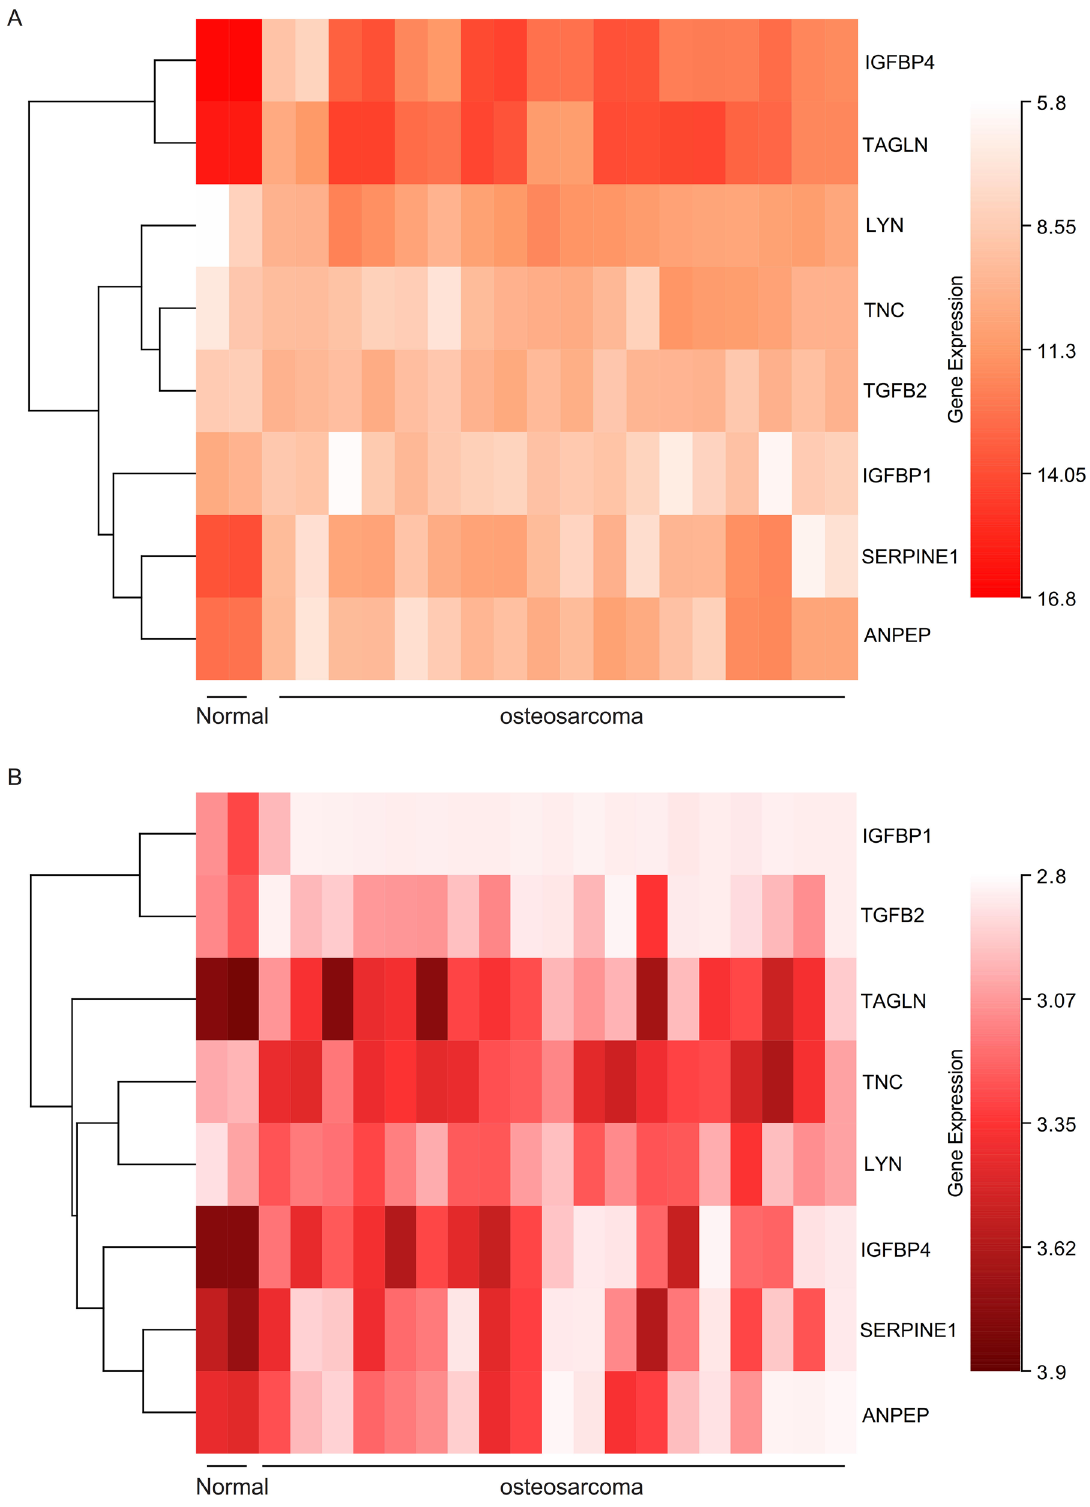
Figure 4. The expression analysis for the hub genes. ( A ) The heat map showed the expressions of the hub genes in GSE14359. ( B ) The heat map showed the expressions of the hub genes in